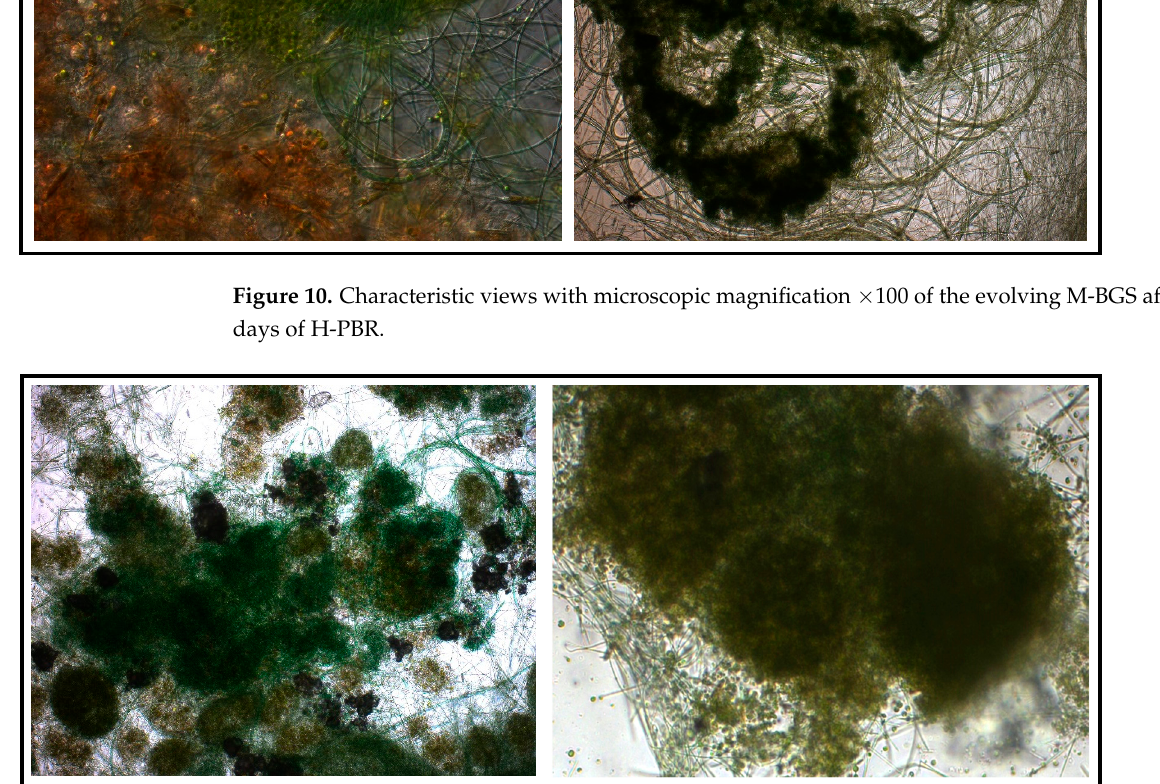
Figure 11. Characteristic views with microscopic magnification × 100 of M-BGS after 60 days of H-PBR